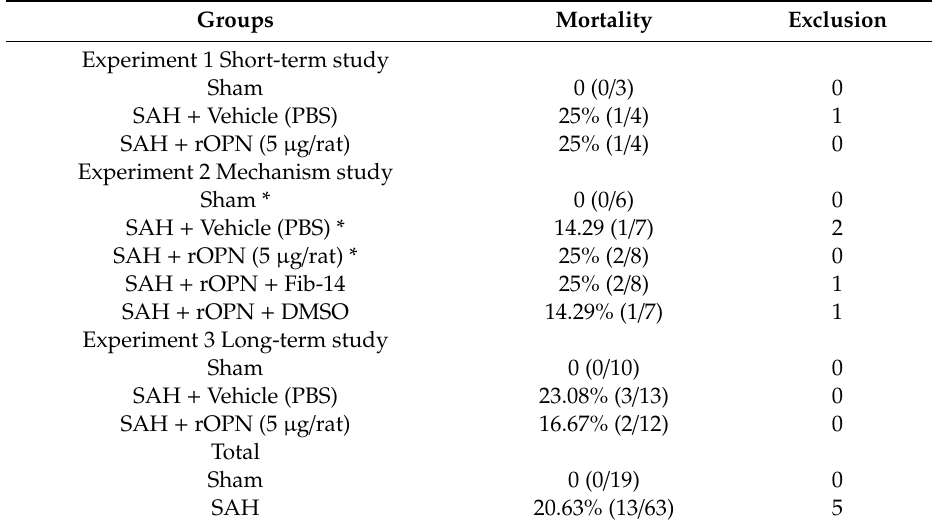
Table 1. Summary of animal usage and